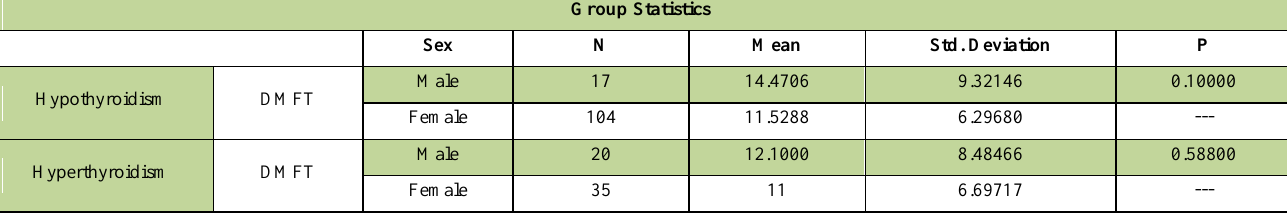
Table 8. Mean and standard deviation of DMFT in two groups of patients by sex.